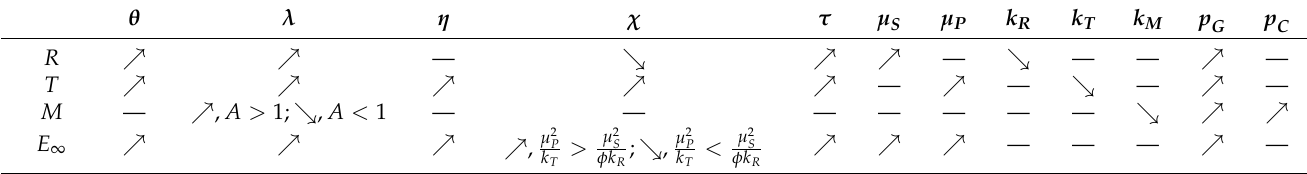
Table 2. A comparative static analysis of the relevant parameters under the NS, CS, and SS sub- sidy